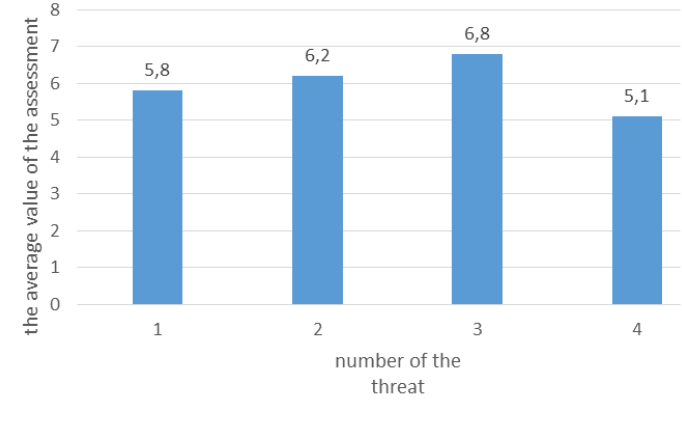
Figure 98: Presentation of paper Fig. 6. The results of the assessment of threats to the learning process